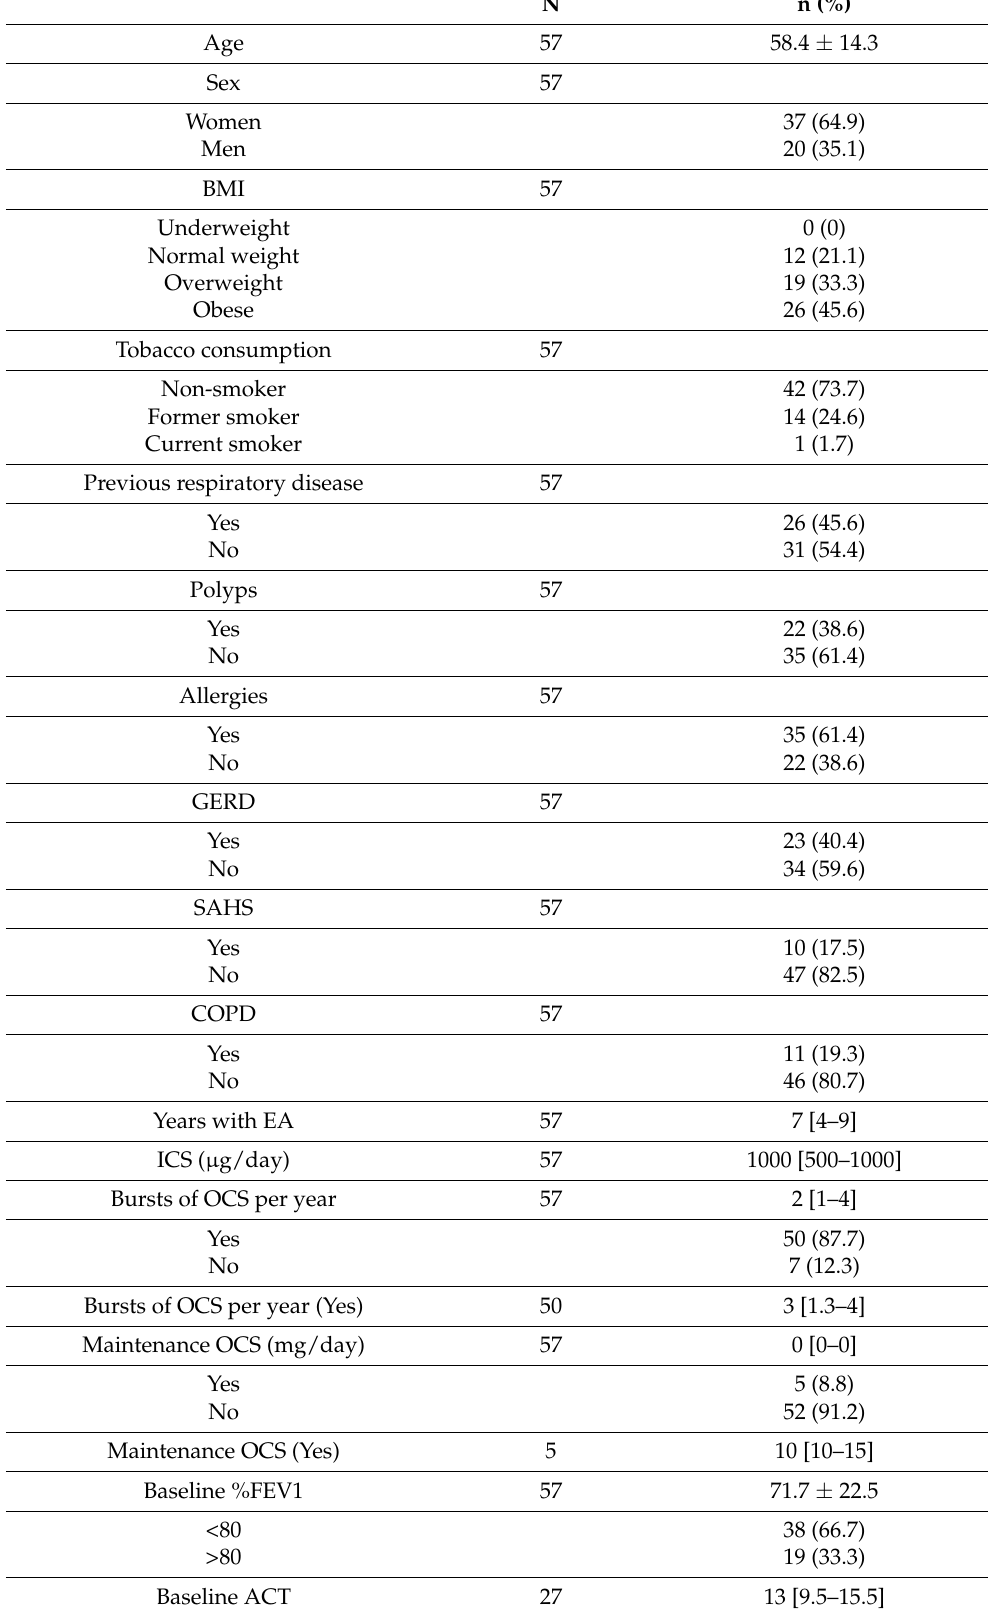
Table 2. Demographic and clinical characteristics of patients treated with